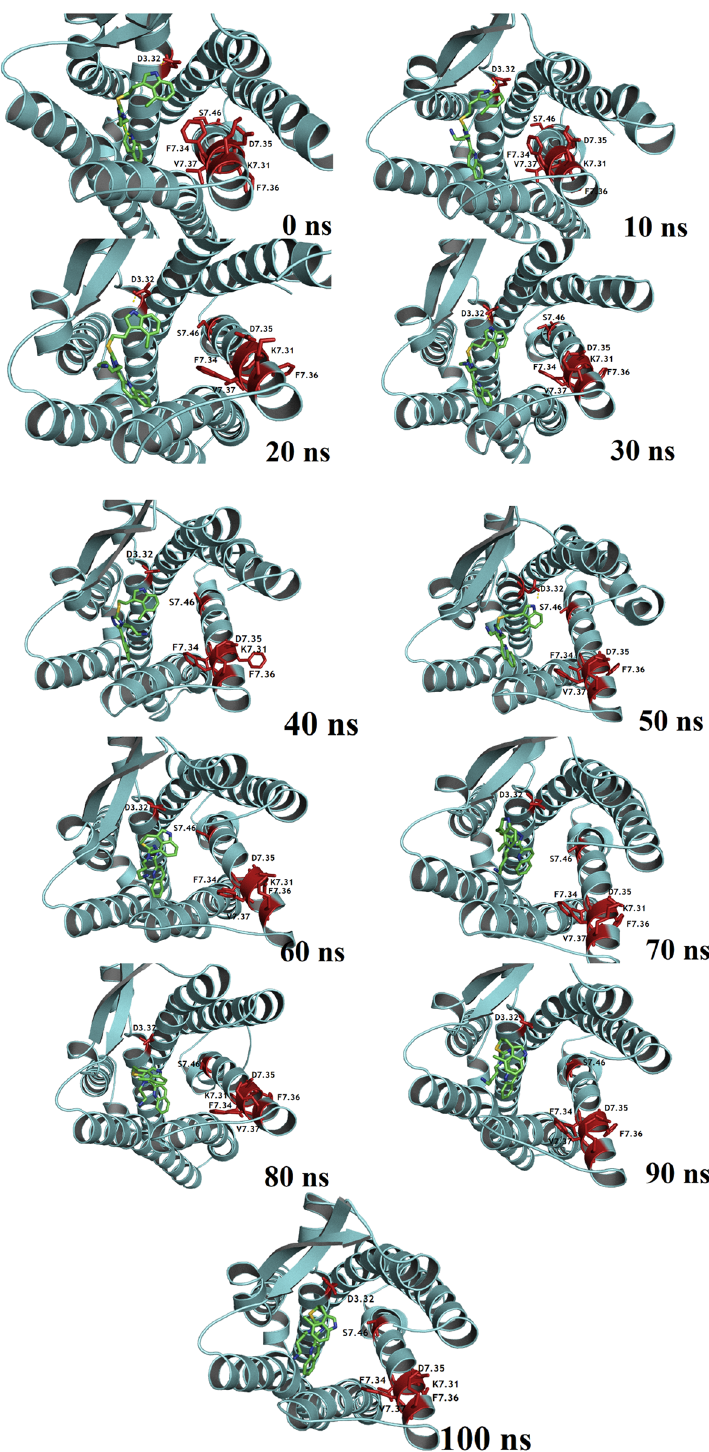
Figure 5. Time evolution of ligand bioactive conformation of compound 46 inside SSTR2 binding site. Figure generated using PyMOL 1.3 (http:// www. pymol.